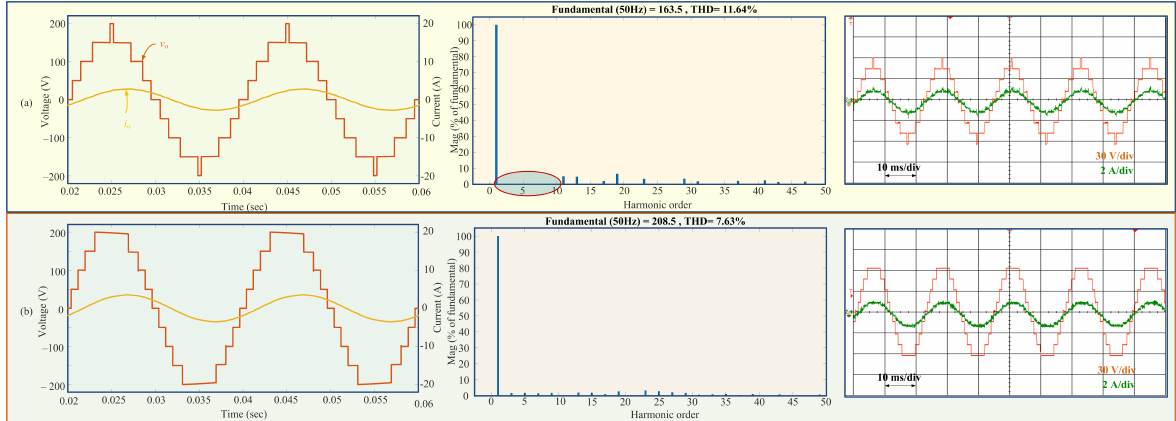
Figure 4. Simulation result, output voltage total harmonic distortion (THD), and experimental result of ( a ) Selective Harmonic Elimination (SHE) and ( b ) selective harmonic mitigation (SHM) pulse width modulation (PWM)